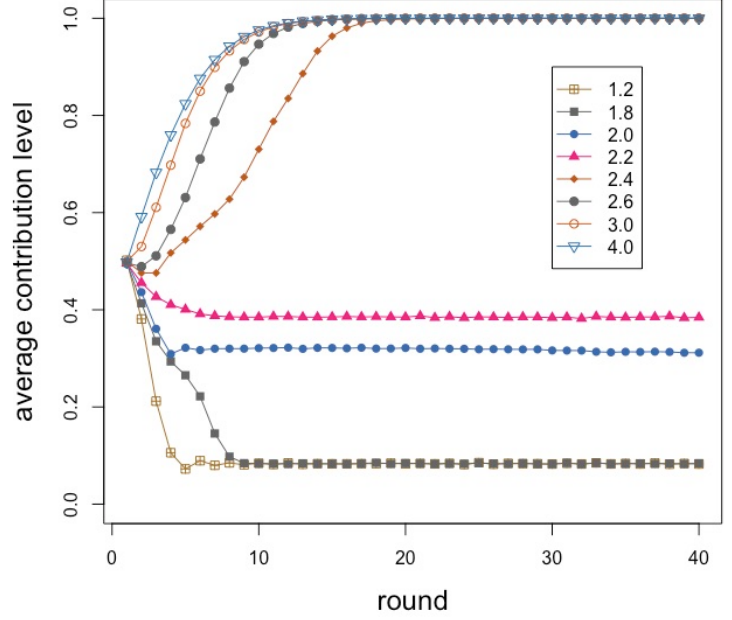
Figure 2. Average individual contribution as a function of round number for several values of the enhancement factor r as shown in the inset. The average is taken over 40 independent repetitions of 40 rounds each on a network of size 500 and α =